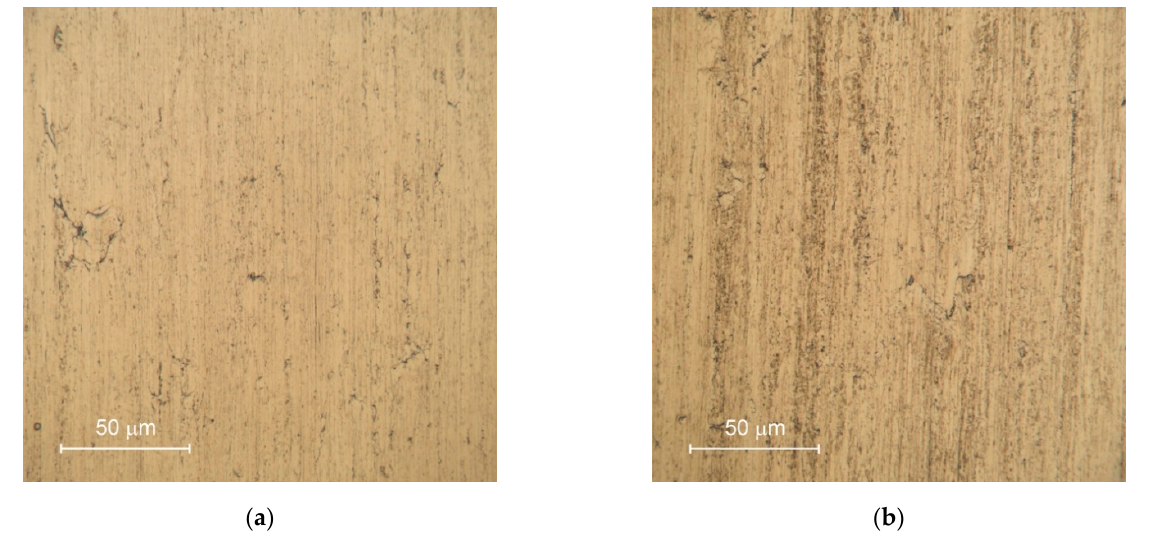
Figure 1. Pictures of two representative AISI 430 ferritic stainless steel samples with different visual appearances: with a mirror-like finish ( a ) and with a presence of haze ( b ). Pictures were taken with a 100× magnification objective, and the field of view was 184.2 μ m × 184.2 μ m.